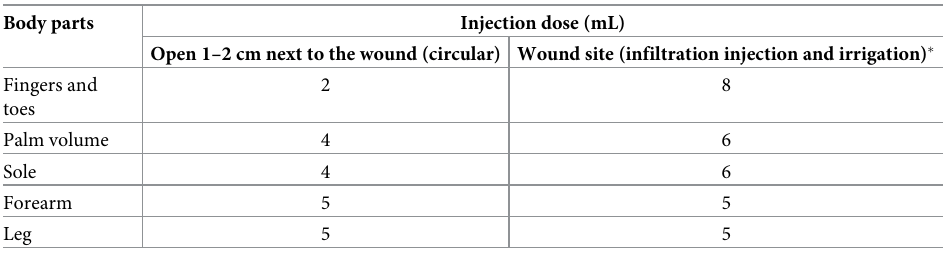
Table 1. Injection dose for different body parts for local blocking therapy. Body